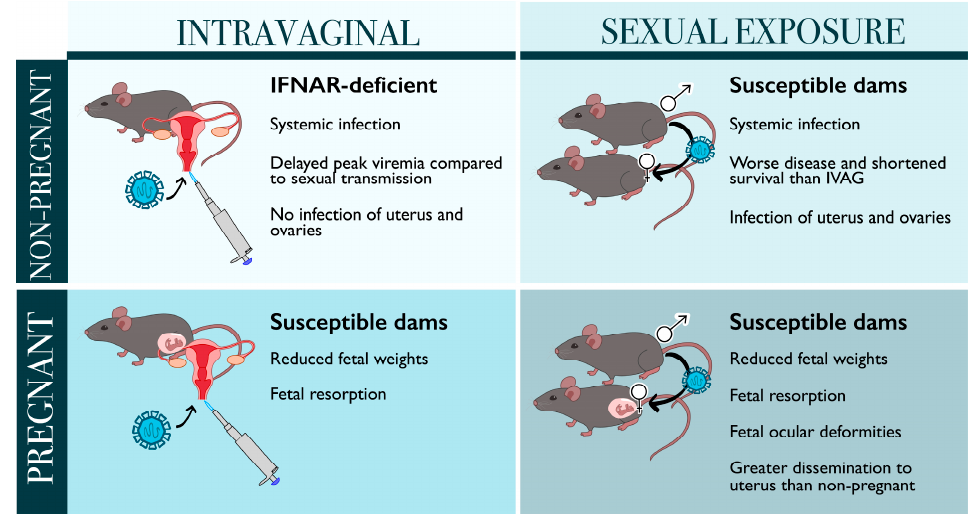
Figure 2. Models of sexually transmitted ZIKV infections in both pregnant and non-pregnant mice. Sexual transmission results in worse survival and greater dissemination to the uterus and ovaries in non-pregnant females compared to intravaginally infected (IVAG) mice. Both intravaginal infection and sexual exposure can impair fetal development, but these clinical outcomes have not been directly